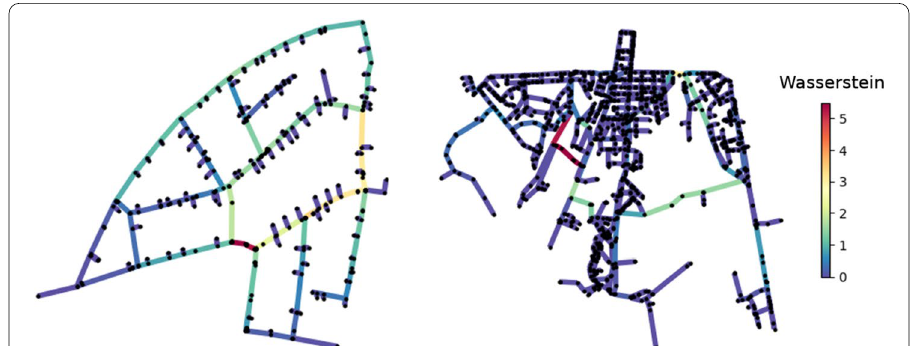
Fig. 6 Heatmap of edge wise criticality for Neptun (left) and Abbiategrasso (right). The colour associated to each edge ( i , j ) is an index of criticality given by the WST distance between G and G \ ( i , j